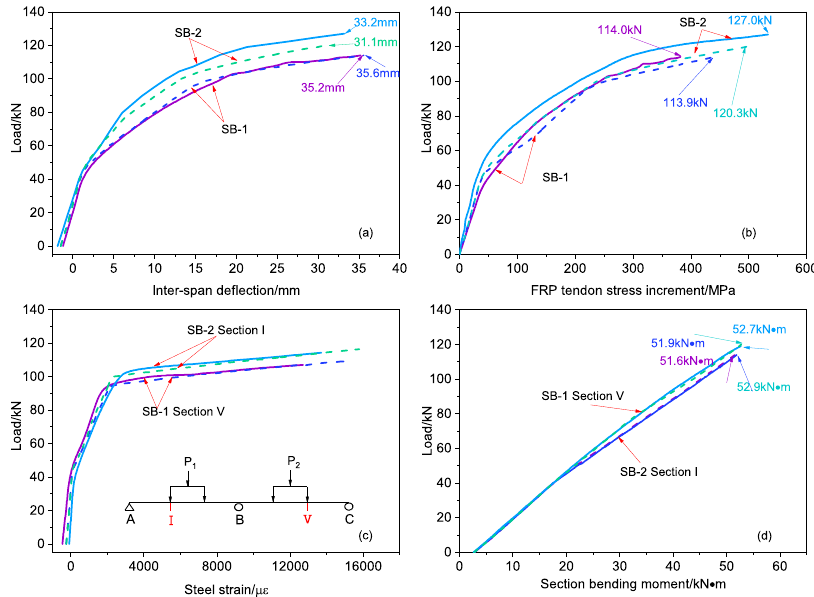
Figure 8. The curve of our group beam between test and FEA results (the dotted line is the simulation value and the solid line is the test value): ( a ) load–span deflection, ( b ) load–external stress increment, ( c ) load–reinforcement strain, ( d ) section bending